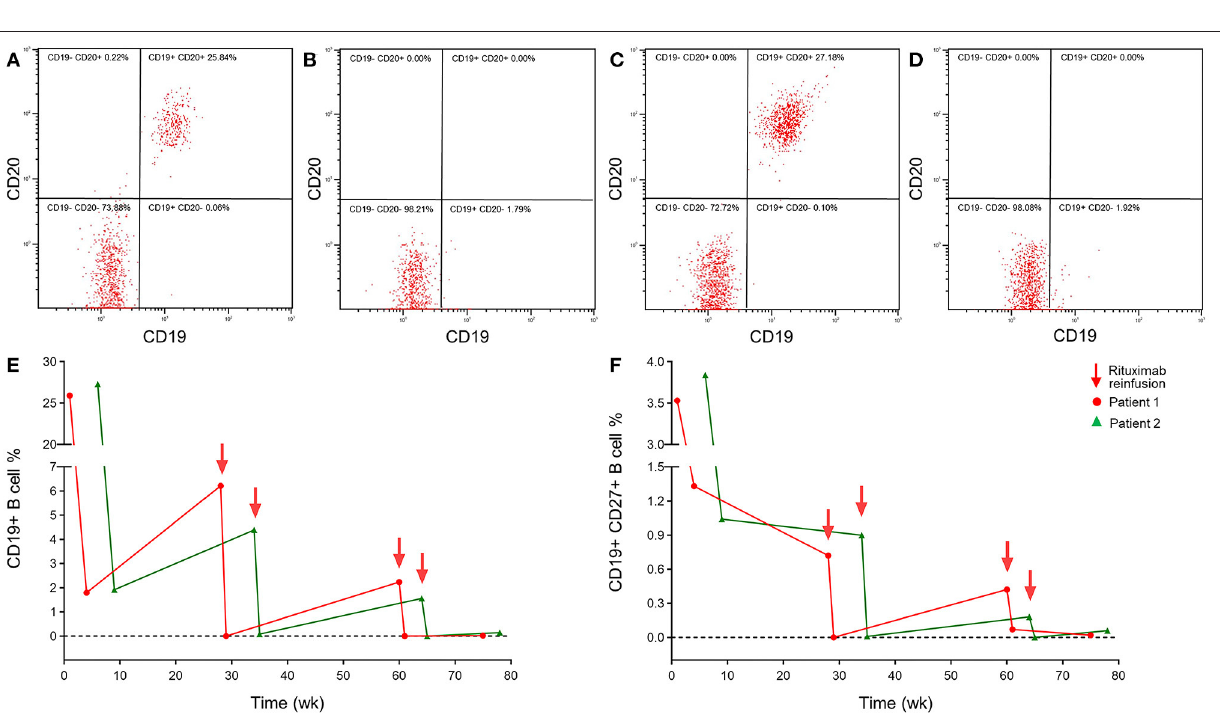
count of 1.33%. After discharge, oral 30 mg prednisone and 200 mg azathioprine were tapering 5 and 50 mg every 2 weeks, respectively, until withdrawal within 2–3 months, and repeated 100 mg RTX was administered every 6 months without relapse during the 1-year follow-up. A total of 6 months